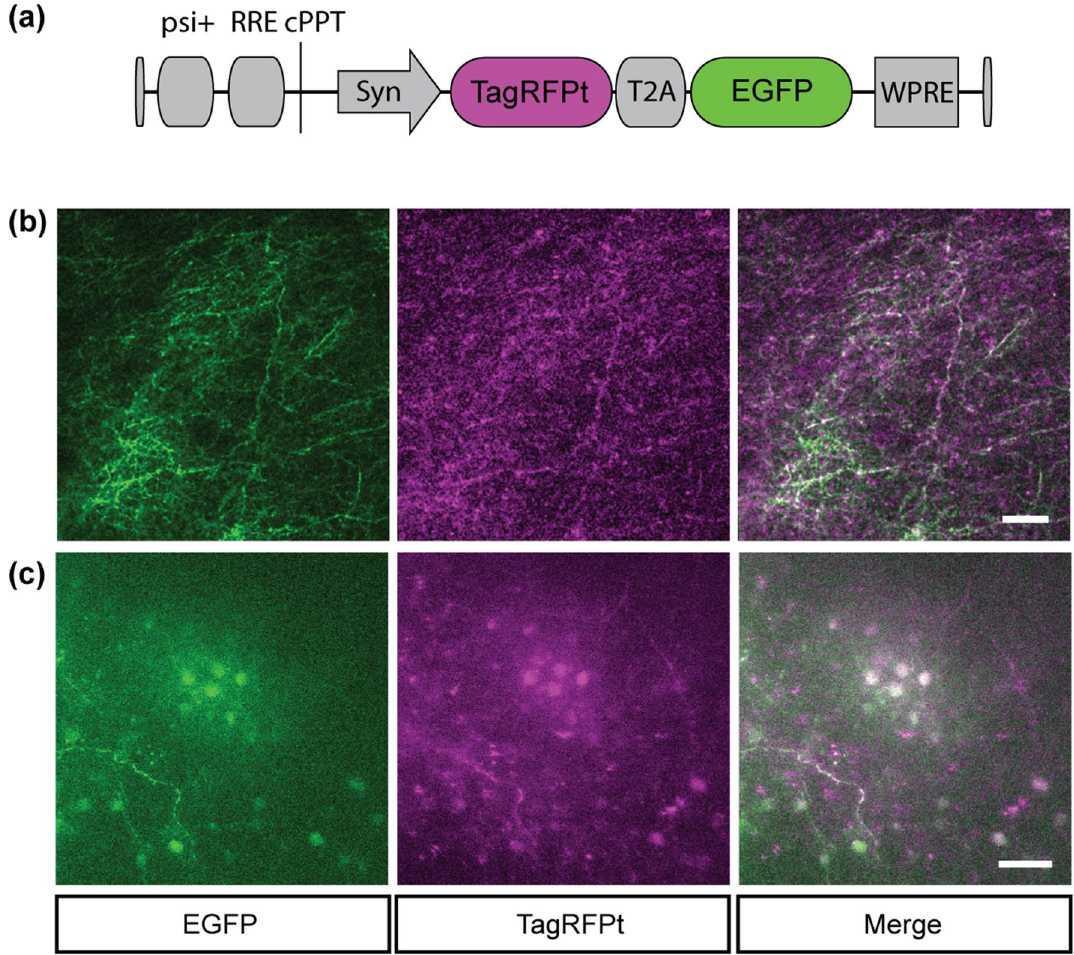
Figure 3. RFP for multi-color intravital 2PM. ( a ) Schematic of pLV-Syn-TagRFPt-T2A-EGFP. ( b ), ( c ) Co-registration of EGFP and TagRFPt, excited by the Ti:Sapphire laser at 900 nm and the YFLS at 1030 nm, respectively. ( b ) The dendrites in the superficial cortex and ( c ) cell bodies at the depth of 300 µm. Scale bars, 50